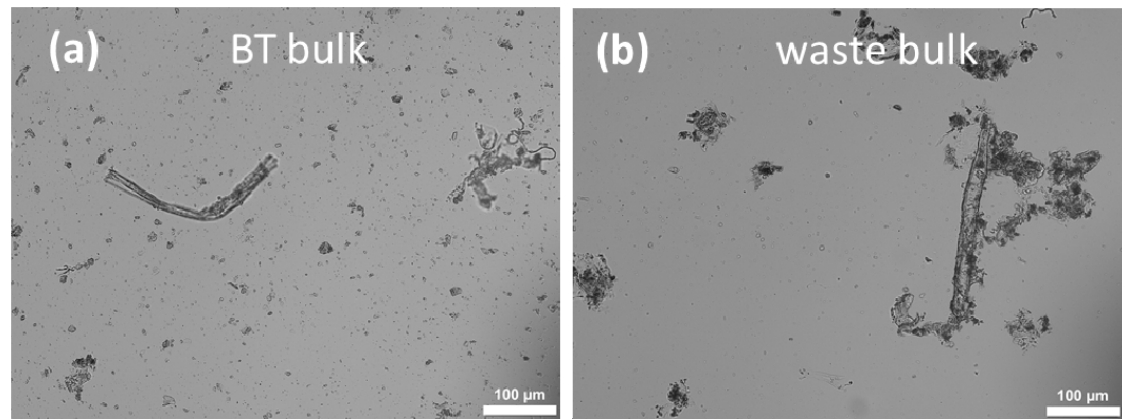
Figure 3. Light microscopic images of the produced bulk-suspensions: black tea (BT) leaves (a) and their waste (b) (200-fold magnification).